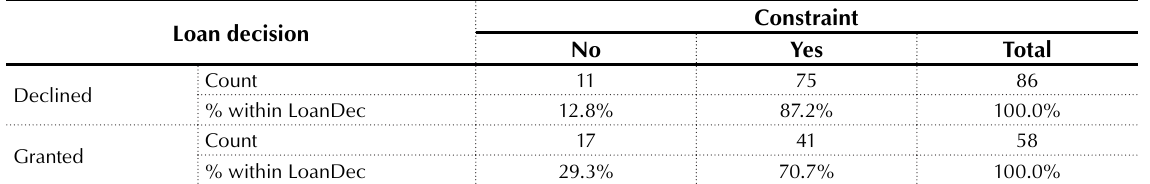
Table 6. Importance of a loan